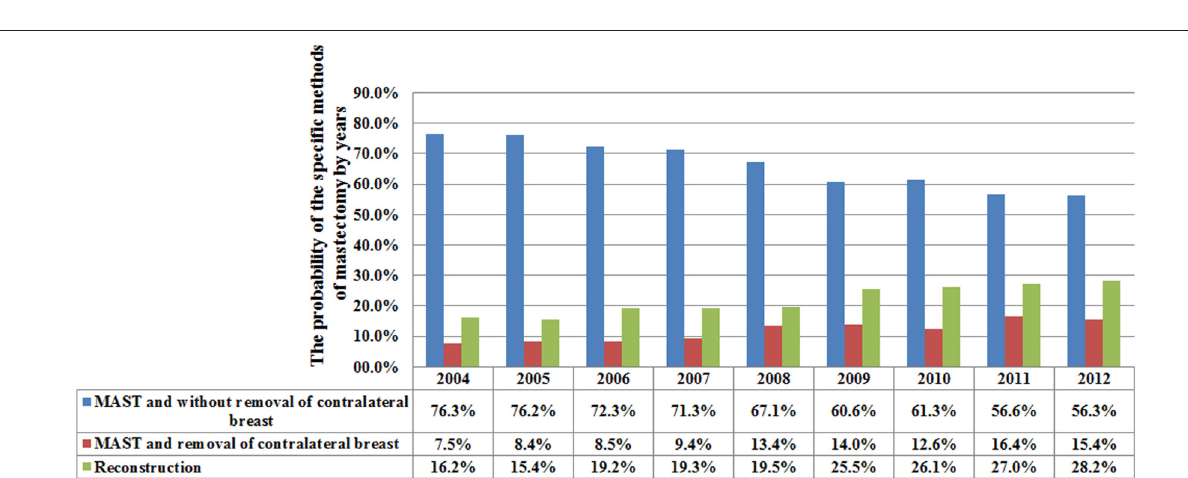
Frontiers in Oncology |